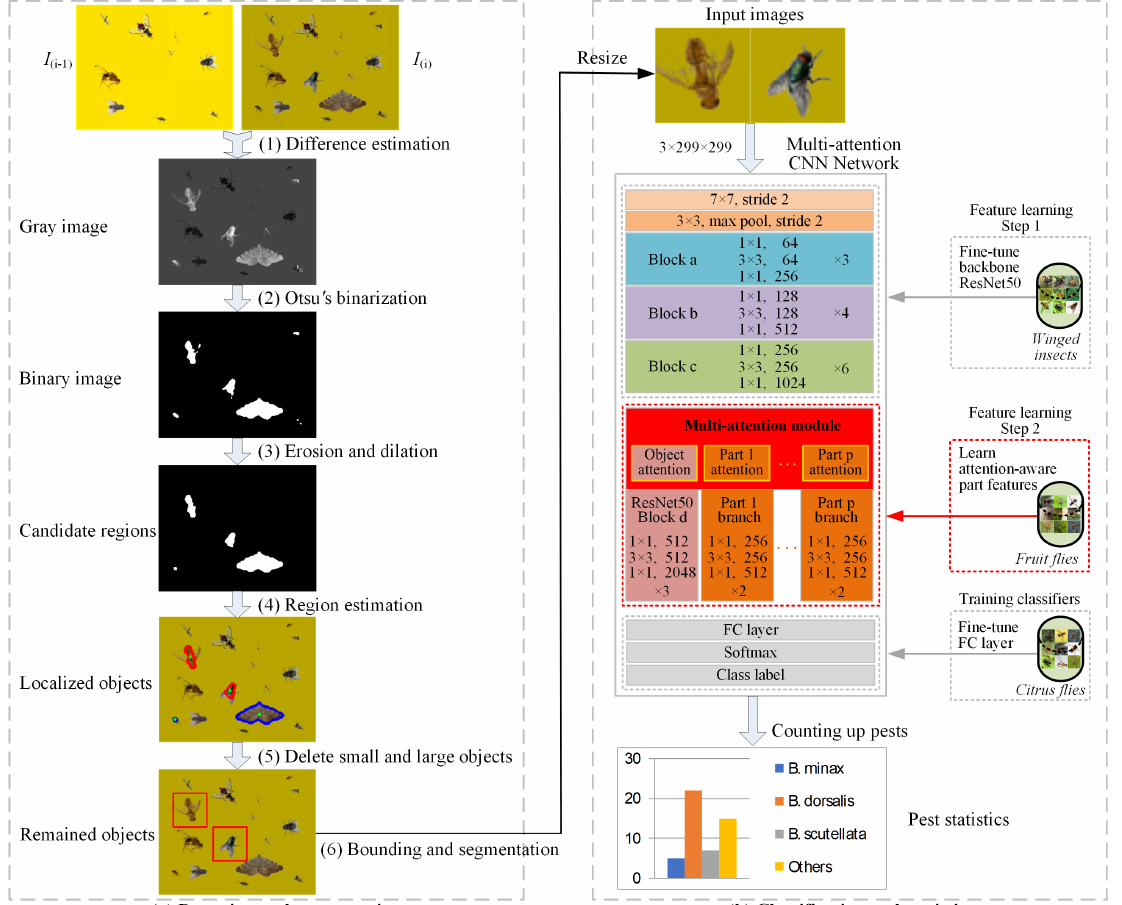
Figure 3. An overview of detecting and recognizing citrus flies. ( a ) Detection and segmentation . (1) The difference between two successive sampled images is converted to a gray image. (2) The Otsu algorithm [44] is performed to obtain a binary image. (3) The morphological transformations are deployed on the white regions of the binary image to generate the candidate areas. (4) The contours, centers, and areas of candidate regions are estimated, and the possible objects in I ( i ) are localized. (5) Some small and large objects are further filtered out according to the objects’ areas. (6) Finally, the remained objects are segmented using a fixed-size bounding box, and the segmented images are resized. ( b ) Classification and statistics . The segmented and resized insect images from the detection phase are fed to the trained MAMPNet (Multi- Attention and Multi-Part convolutional neural Network), which learn the object-level and attention-aware part features of citrus flies on the multiple constructed datasets. Each detected insect is classified as one of 15 possible species of insects. Finally, the statistical results of three target species of citrus fly pests, i.e., B. minax , B. dorsalis and B. scutellata , are